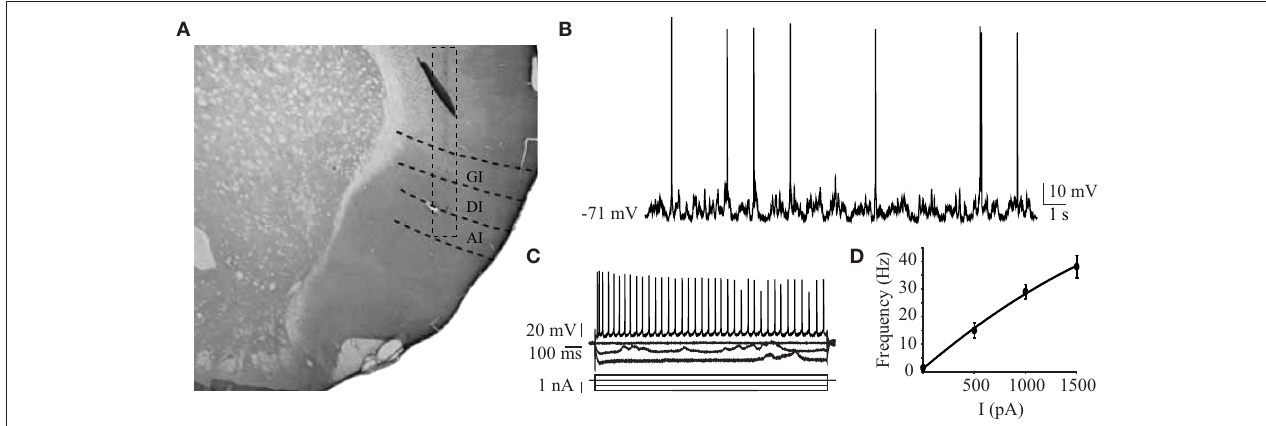
spontaneous activity in a GC neuron from urethane anesthetized rats. (C) Responses to hyperpolarizing and depolarizing current pulses of a representative neuron. The firing behavior observed was that of a regular spiking neuron. (D) The average f/I curve for 12 neurons. Data are presented as mean ± SEM. x -axis: current injected, y -axis: frequency of